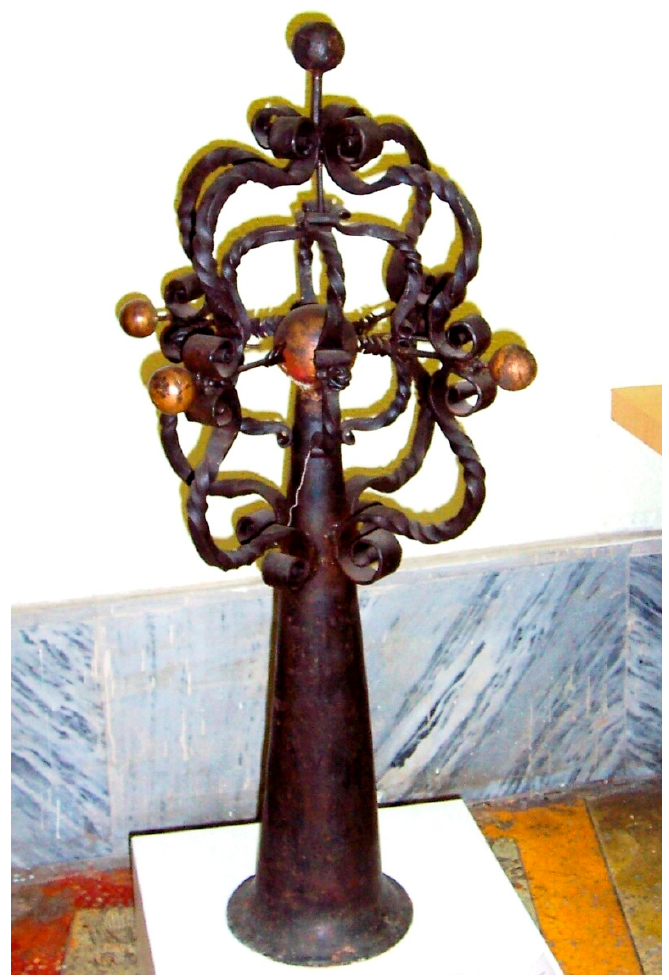
Figure 5. Buryat blacksmith Radna Sanzhitov’s sculpture “Surkharban”, wrought iron, 1987. Photo: Stefan Krist (by courtesy of the Sampilov Fine Art Museum of the Republic of Buryatia).